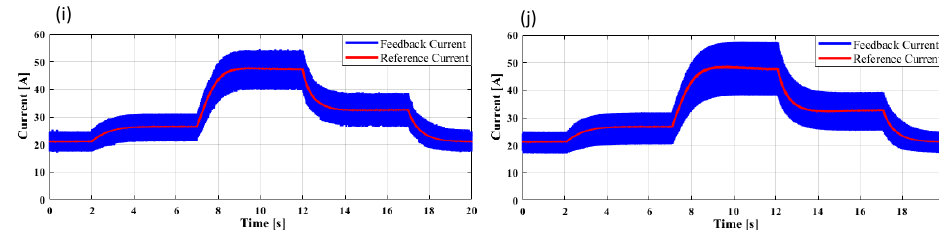
Figure 11. Faulty condition DoS results in time domain. ( a ) Three–phase line voltages of PMSG. ( c ) Three–phase stator currents of PMSG. ( e ) Output voltage of the three–phase diode rectifier. ( g ) Rotor speed of PMSG. ( i ) Feedback and reference currents at the input of boost converter. Faulty condition DRTS results. ( b ) Three–phase line voltages of PMSG. ( d ) Three–phase stator currents of PMSG. ( f ) Output voltage of the three–phase diode rectifier. ( h ) Rotor speed of PMSG. ( j ) Feedback and reference currents at the input of boost converter.